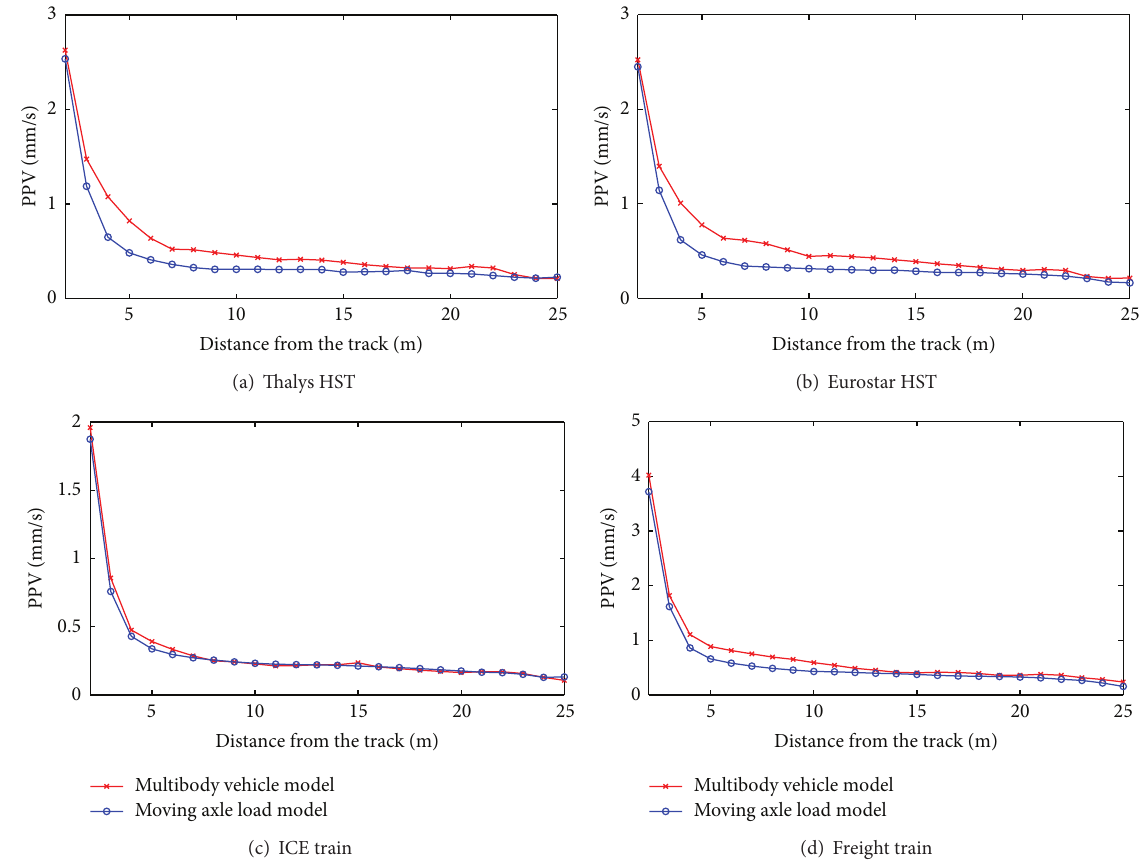
Figure 11: Influence of the vehicle type on the peak particle velocity, at various distance from the track ( V 0 = 150 km/h).